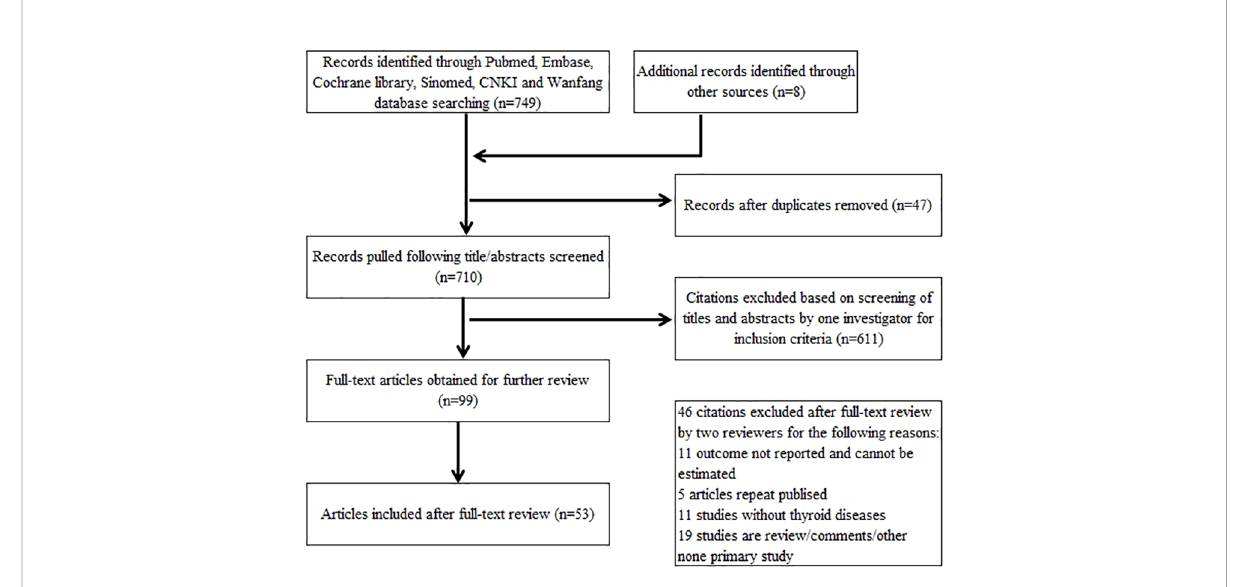
FIGURE 1 Flowchart of the systematic search